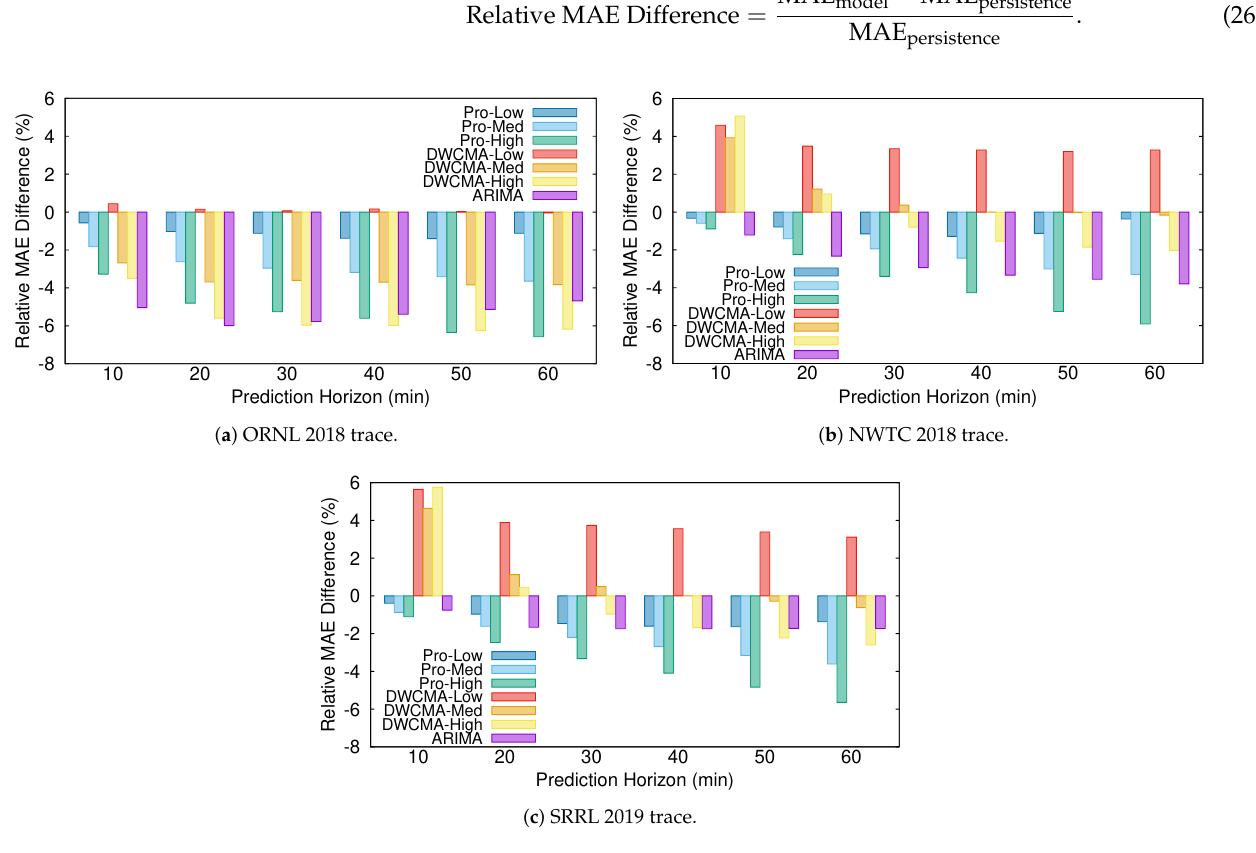
Figure 4. Relative mean absolute error (MAE) difference (persistence model used as